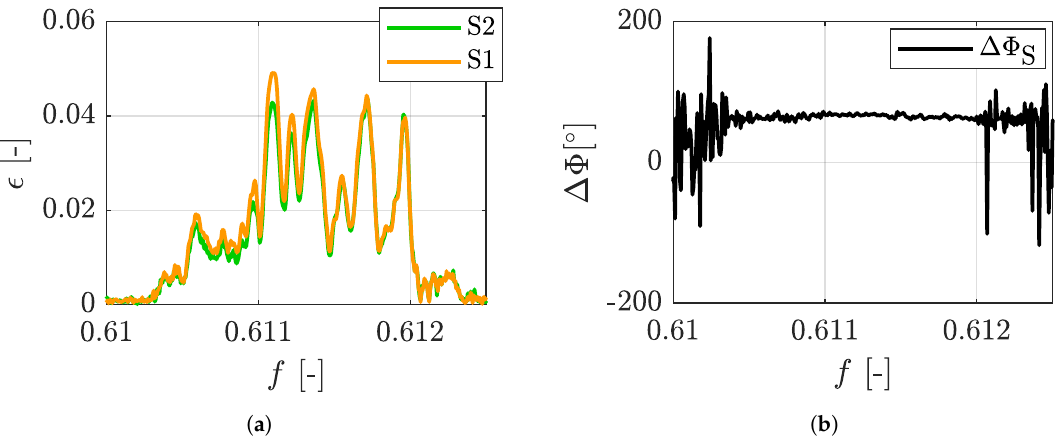
Figure 14. EO17: Shaft vibrations, frequency domain and phase lag. ( a ) Zoom on EO17 excited normalized amplitude of shaft SGs during rotational speed of M8EO24; ( b ) Zoom on EO17 excited phase lag ∆ Φ S of shaft SGs during rotational speed of